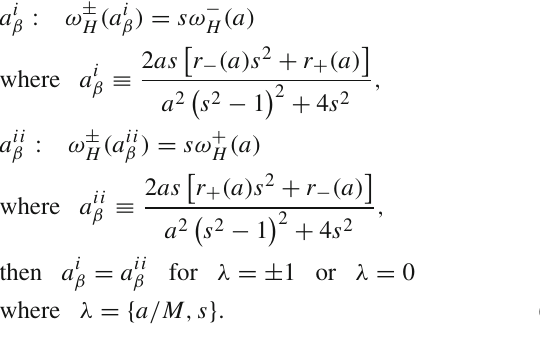
plotshowsthelogarithmidentityasdiscussedinthetext.Here a + = a − and a + for tangent spin in a g = M . Bundle tangent spin a g as 0 0 horizon spins a